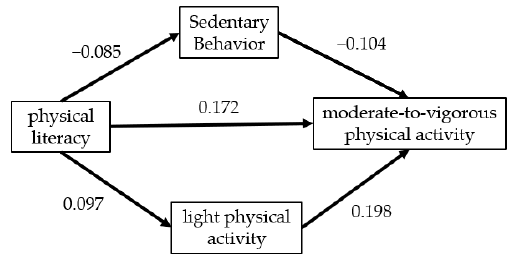
Figure 2. Mediation model diagram of SB and LPA.